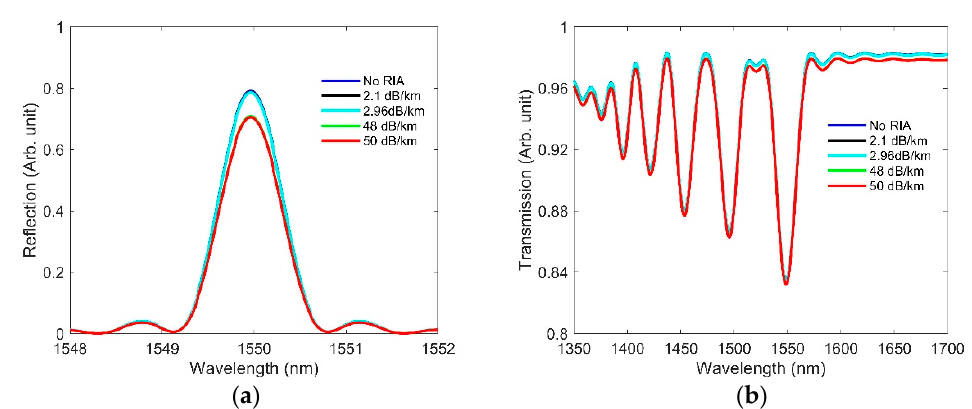
Figure 15. Effect of RIA on the spectra of ( a ) FBG and ( b ) LPG, using the same design parameters applied earlier.